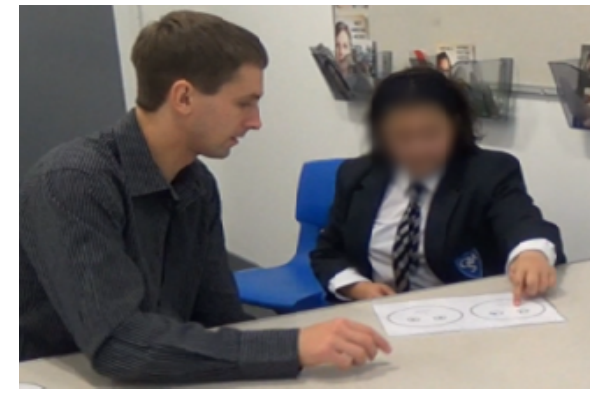
Figure 7: Child participating in the Smarties test.